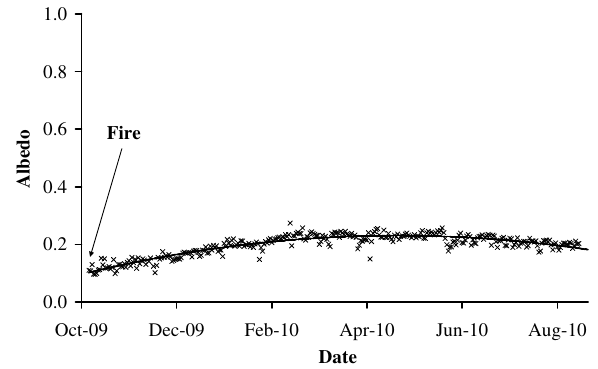
Fig. 4. The change in albedo of the Mfabeni Mire following the recovery of vegetation after a fire in September 2009.